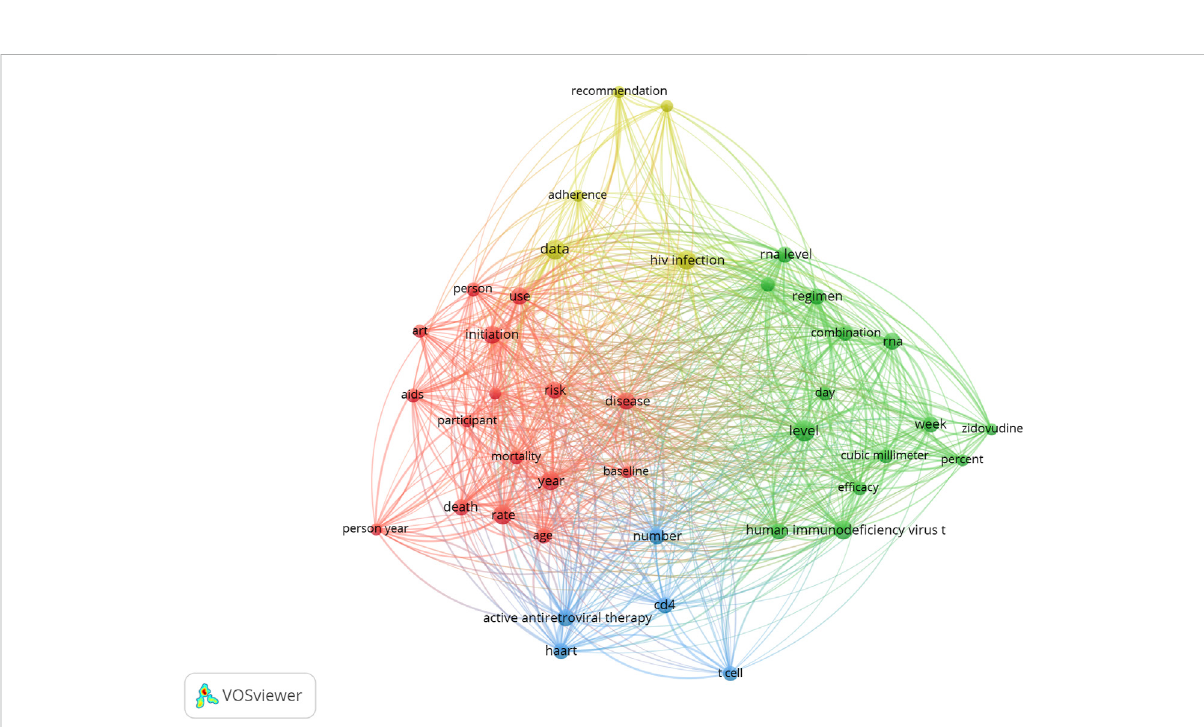
FIGURE 2 Research hotspots of drug therapy for